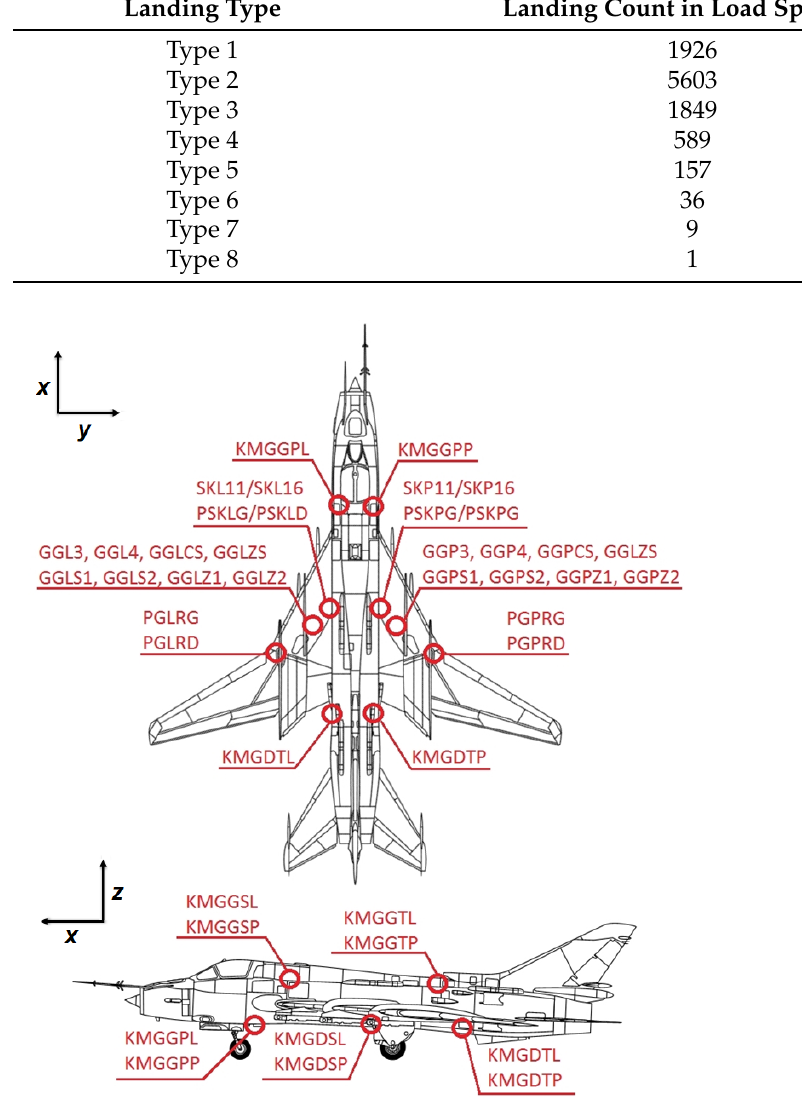
Figure 4. General view of the strain gauge network on the test aircraft (due to the symmetry of the sensor network only one side of the aircraft is